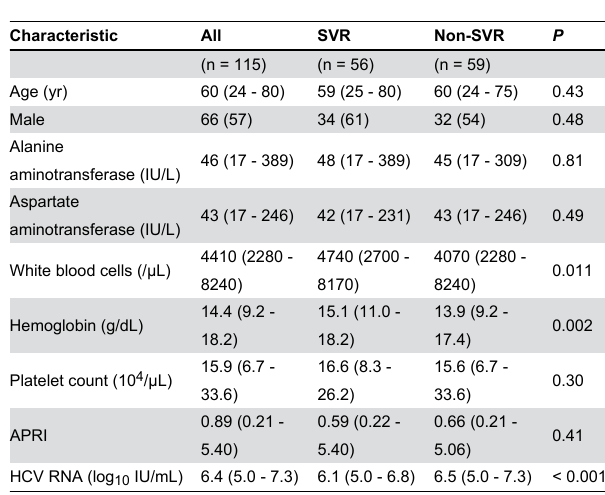
Table 1. Clinical features of sustained and non-sustained virological response patients with chronic hepatitis C.